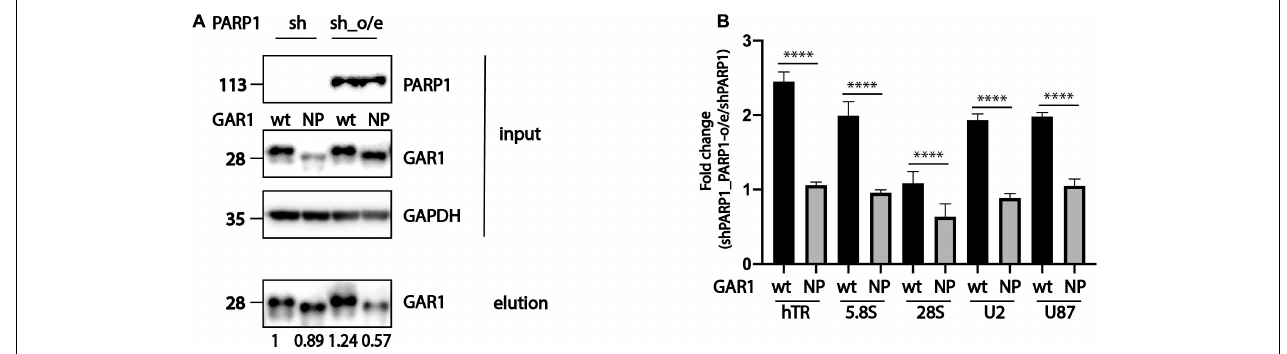
FIGURE 3 | PARylation modulates the ability of RNA-binding proteins to associate with RNA. (A) Western blot analysis of expression of PARP1, GAR1, and NP-GAR1 (input panel) and efficiency of immunoprecipitation (elution panel). (B) RT-qPCR analysis of the levels of RNA co-immunoprecipitated with GAR1. The mean values were calculated from triplicate RT-qPCR experiments with three biological replicates, and the bars represent SE. ∗∗∗∗ P <